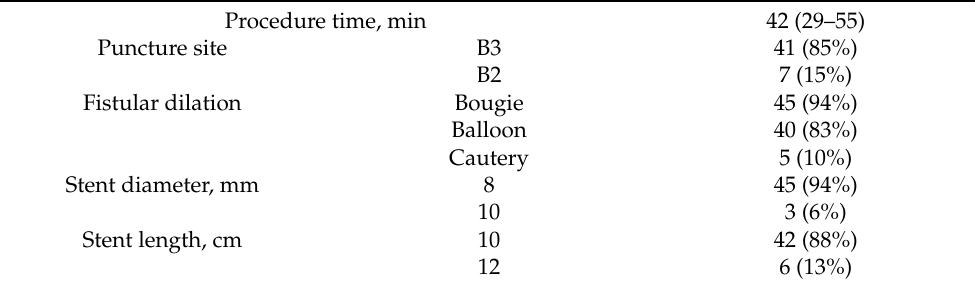
Table 2. Details of the procedure.